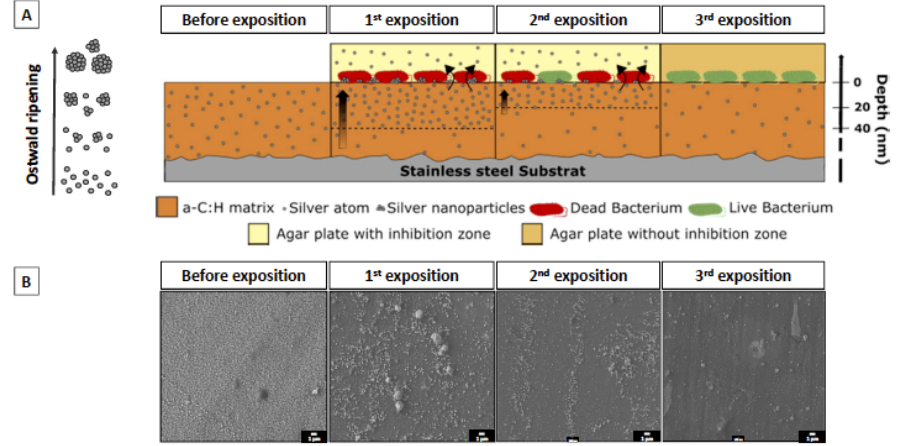
Figure 9. ( A ) Schematic description of the silver release mechanism and the effect on bacteria for multiple exposures. The silver homogeneously deposited along the coating depth moves and accu- mulates at the surface, leading to a high local silver concentration that results in the formation of Ag nanoparticles driven by a self-assembling phenomenon (Ostwald ripening phenomenon). ( B ) Rep- resentative SEM images of the coating surface before and after each bacterial